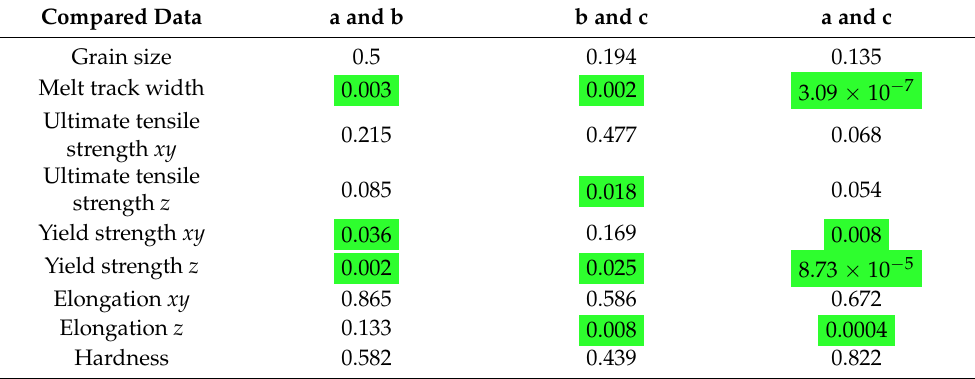
Table 3. p -values for a true null hypothesis of equal means between groups. Alpha of 0.05 used for determination of statistical significance. Data from tests of samples with process settings a, b, and c (Figure 3). p -values less than 0.05 are